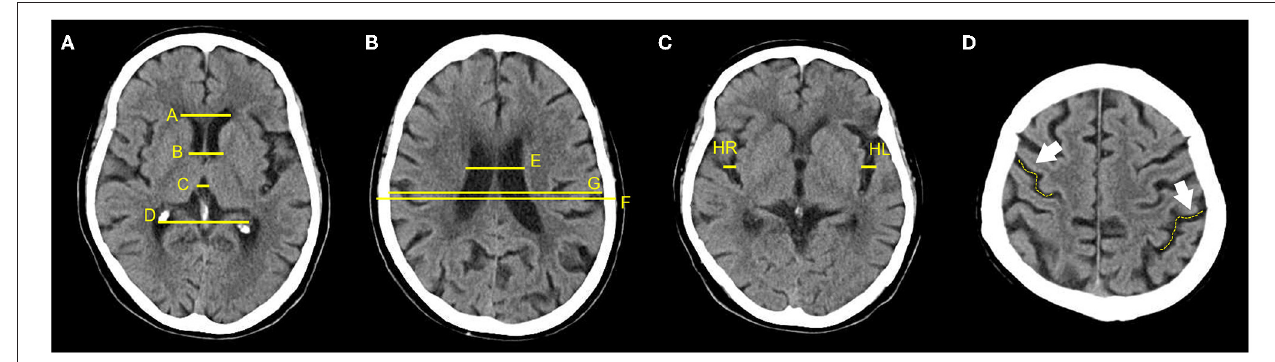
FIGURE 2 | Annotation of 9 linear measurements and cerebral sulci enlargement. (A–D) were four key slices defied for linear measurements and Cerebral sulci enlargement identification. (A) , A, B, C, and D were manually annotated on basal ganglion slice showing most prominently the heads of the caudate nuclei (Key slice 1); (B) , E, F, and G were annotated on slice displaying most of the body of the lateral ventricle (key slice 2); (C) . HL and HR were manually annotated on slice a that the Sylvian fissures were most clearly visualized (key slice 3); (D) , Binary classification of cerebral sulci widening on the third slice above the top of lateral ventricle was also annotated (key slice 4).